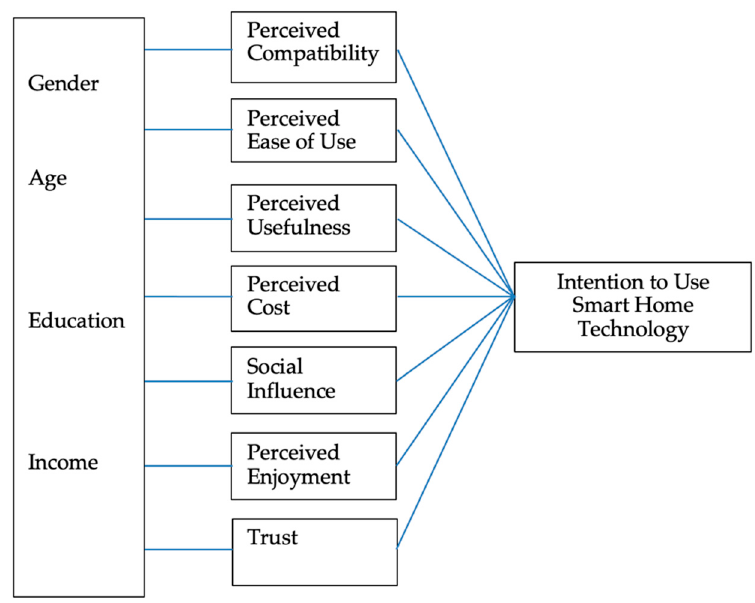
Figure 1. Graphic model of variables’ correlations.